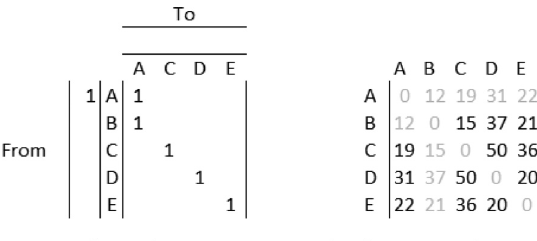
Figure 8. GT revised iteration 1, step